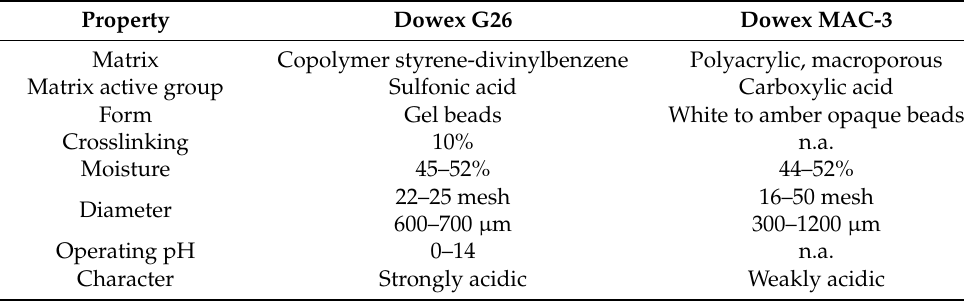
Table 2. Properties of the resins used for Cr(III)